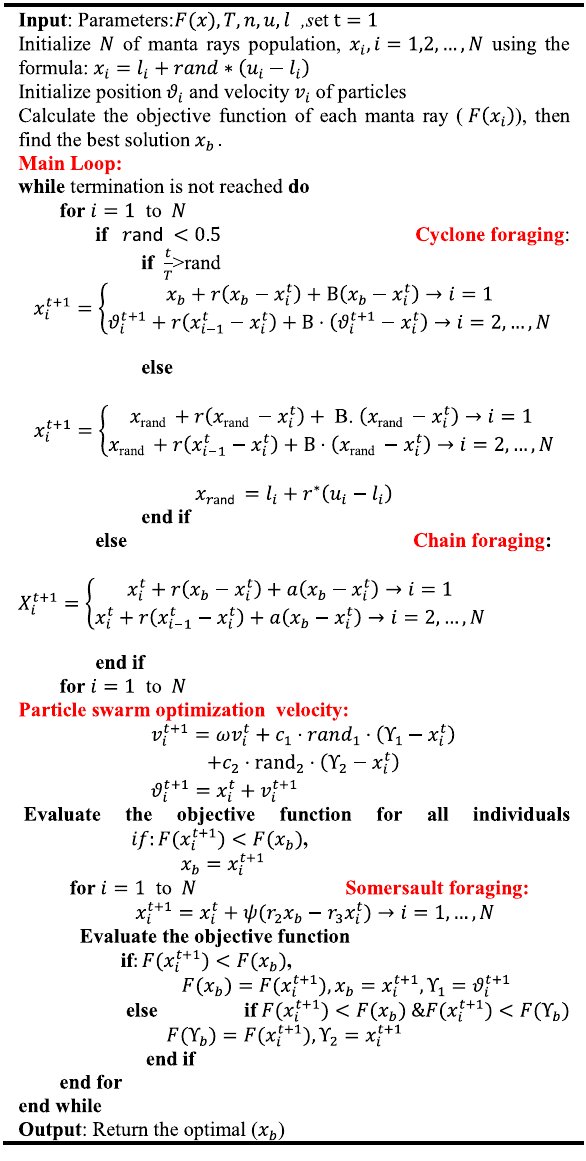
Fig. 1 Pseudocode of MRFO-PSO